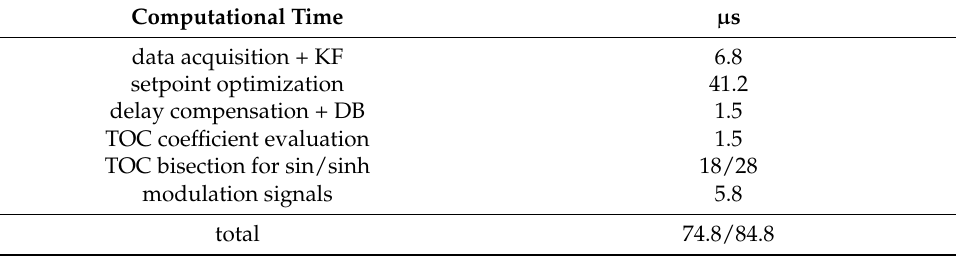
Table 1. Computational times of the control algorithm on DSP